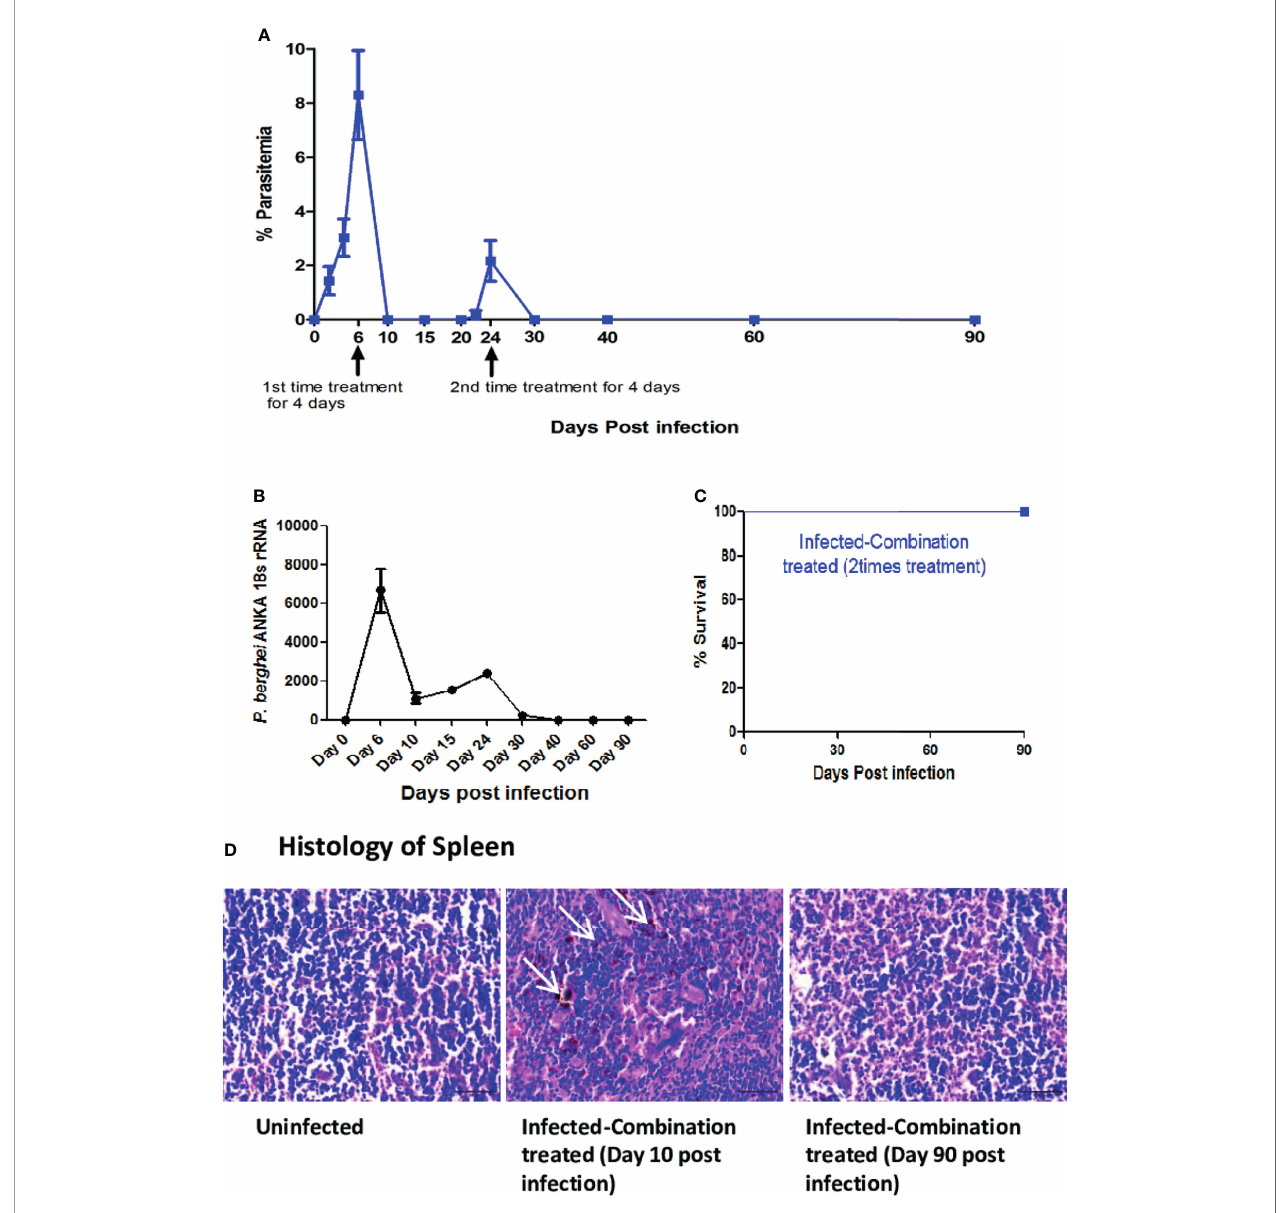
FIGURE 6 | Ef fi cacy of two-time treatment with a combination of ART+AC9+AND+CUR in P. berghei ANKA infected C57BL/6 was evaluated. Treatment with a combination of ART+AC9+AND+CUR was fi rst given from day 6 to 9 p.i and again from day 24 to 27 p.i. after detection of recrudescence, followed by monitoring the (A) Trend in Parasitemia (B) P. berghei ANKA 18s rRNA levels in spleen and (C) Survival curve. Parasitemia, and survival curve data is representative of 3 independent experiments and data from 6 mice per group has been represented. P. berghei ANKA 18s rRNA levels have been quantitated from 3 mice per group and data is representative of 3 independent experiments. (D) Histology of spleen sections from uninfected and infected-combination treated group on day 10 and day 90 p.i. White arrows indicate the sequestration of infected erythrocytes in the sinusoids. Data is representative of 3 independent experiments. Scale bar: 30 m